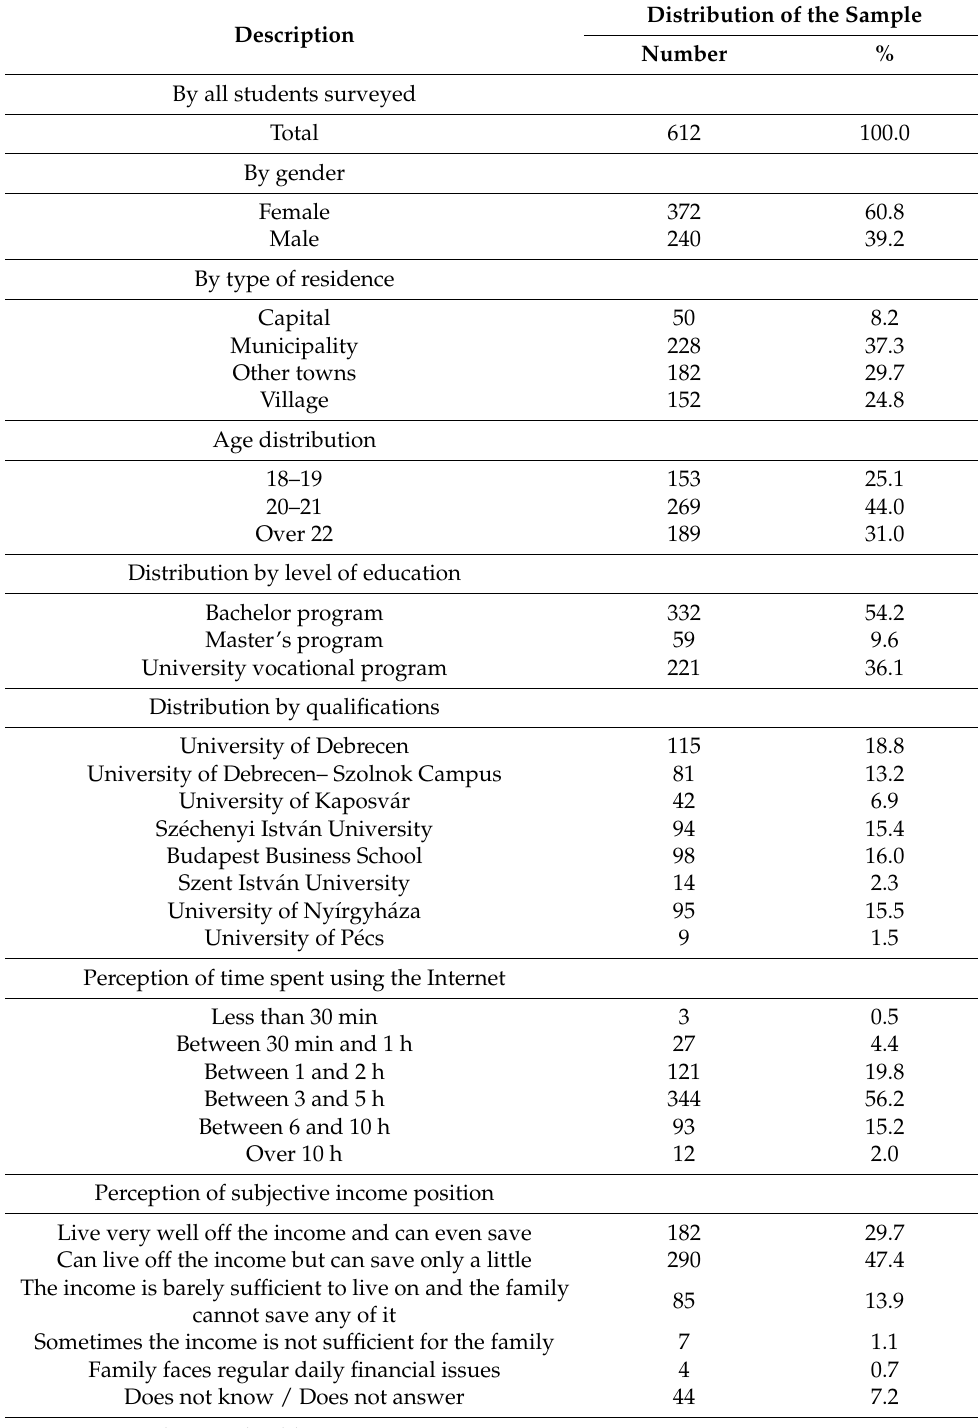
Table 1. Sociodemographic background of the